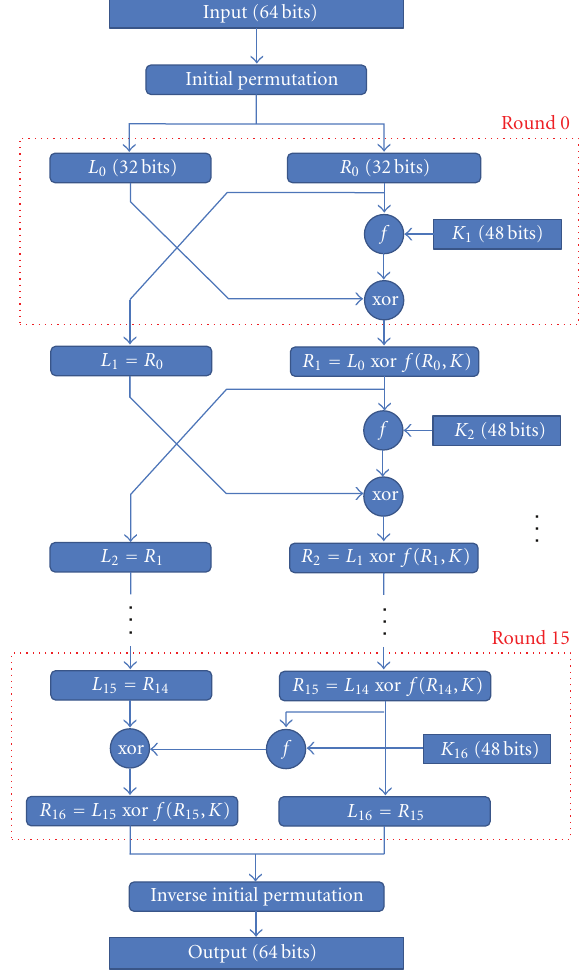
Figure 17: The DES